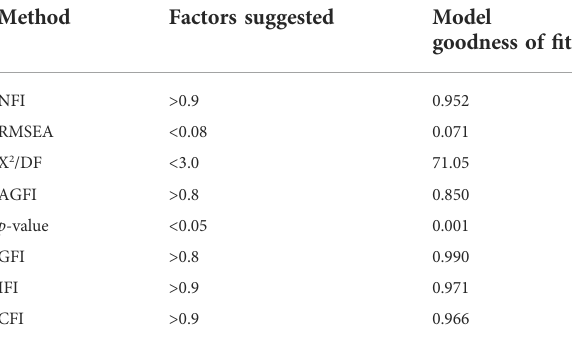
TABLE 8 Results of the goodness of fi t of the model.